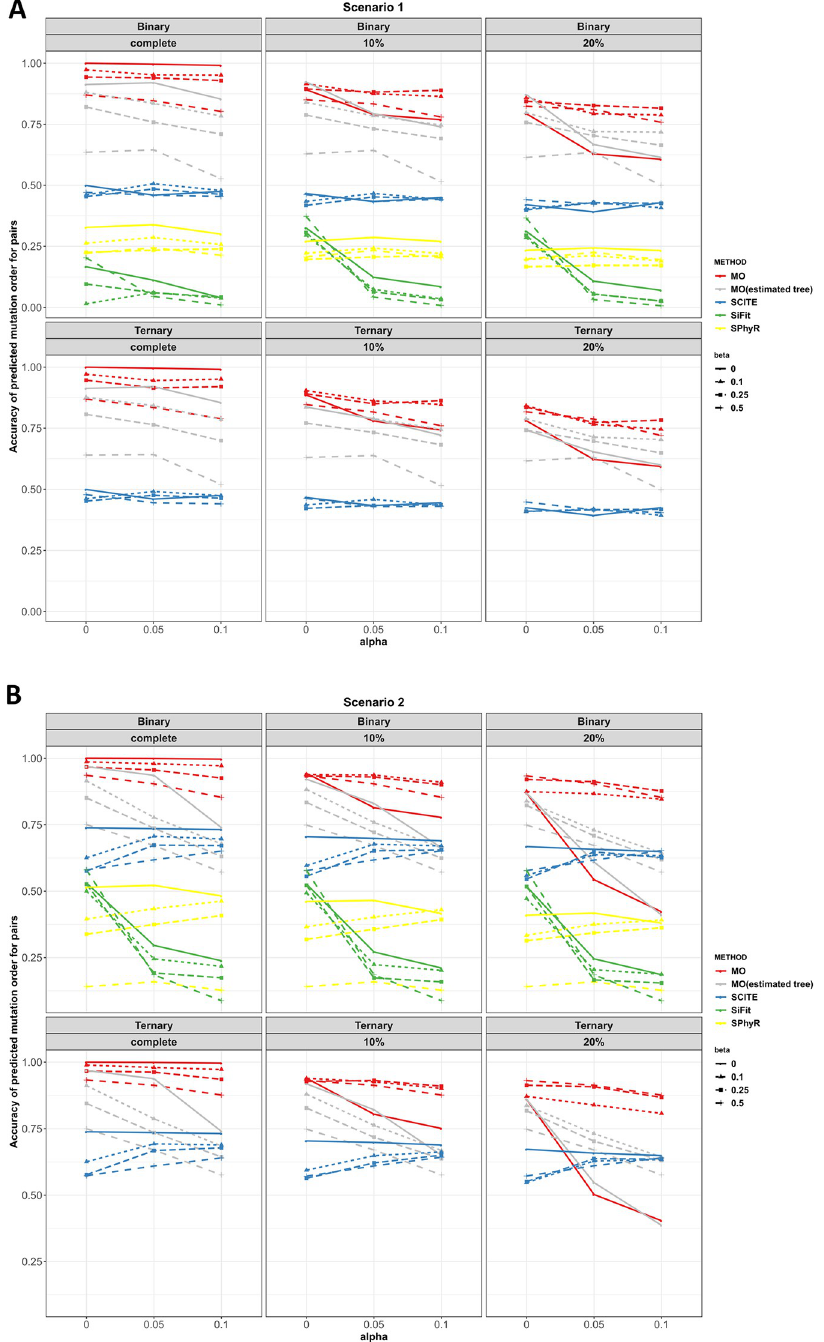
Fig 4. Order accuracy in scenarios 1 and 2 for MO, SCITE, SiFit and SPhyR when there are 20 mutations. Each panel includes the results from the specific type of genotype and missing data percentage. In each panel, red, gray, blue, green and yellow colors correspond to MO with the true tree, MO with the estimated tree, SCITE, SiFit and SPhyR, respectively. Each plotting symbol on the line represents a different β . The x-axis is the probability of a false positive error and the y-axis is order